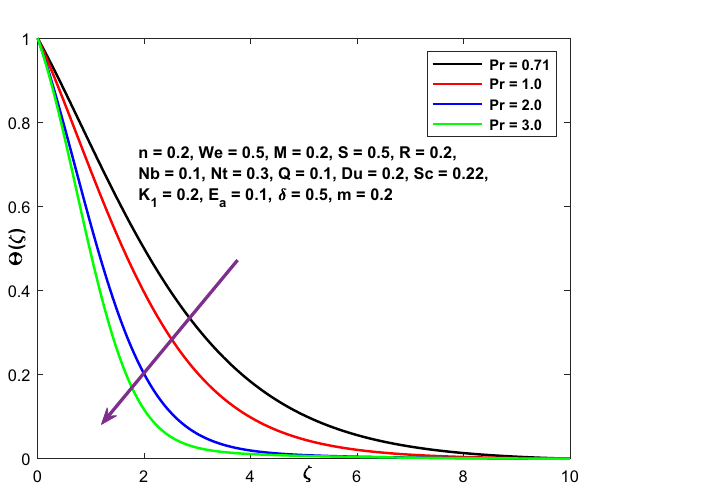
Figure 12. Character of Pr versus �(ζ)